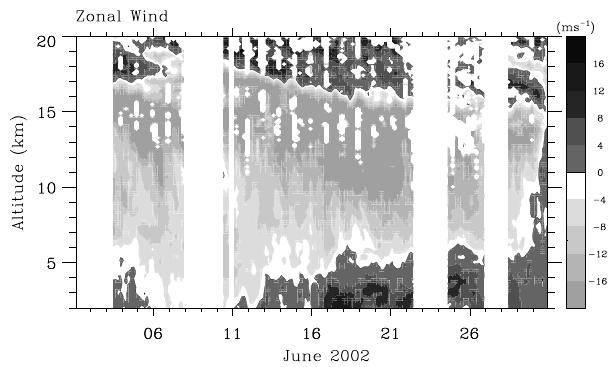
Fig. 6. Time variations of (a) zonal and (b) meridional wind derived from EAR and NCEP/NCAR reanalysis. Solid and dotted curves Fig. 7. Time-altitude plot of zonal wind observed by EAR in June Fig. 7. Time-altitude plot of zonal wind observed by EAR in June show EAR winds averaged in 3–4.5 km and NCEP winds averaged 2002. 2002. in 700–600 hPa closest to the observation site ( spectively.